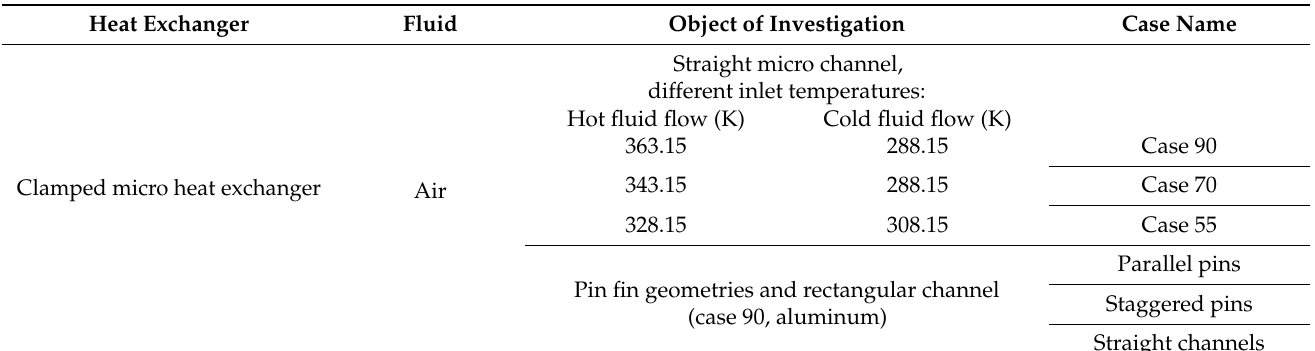
Table 6. Operating conditions for the clamped microstructure heat exchanger examined with